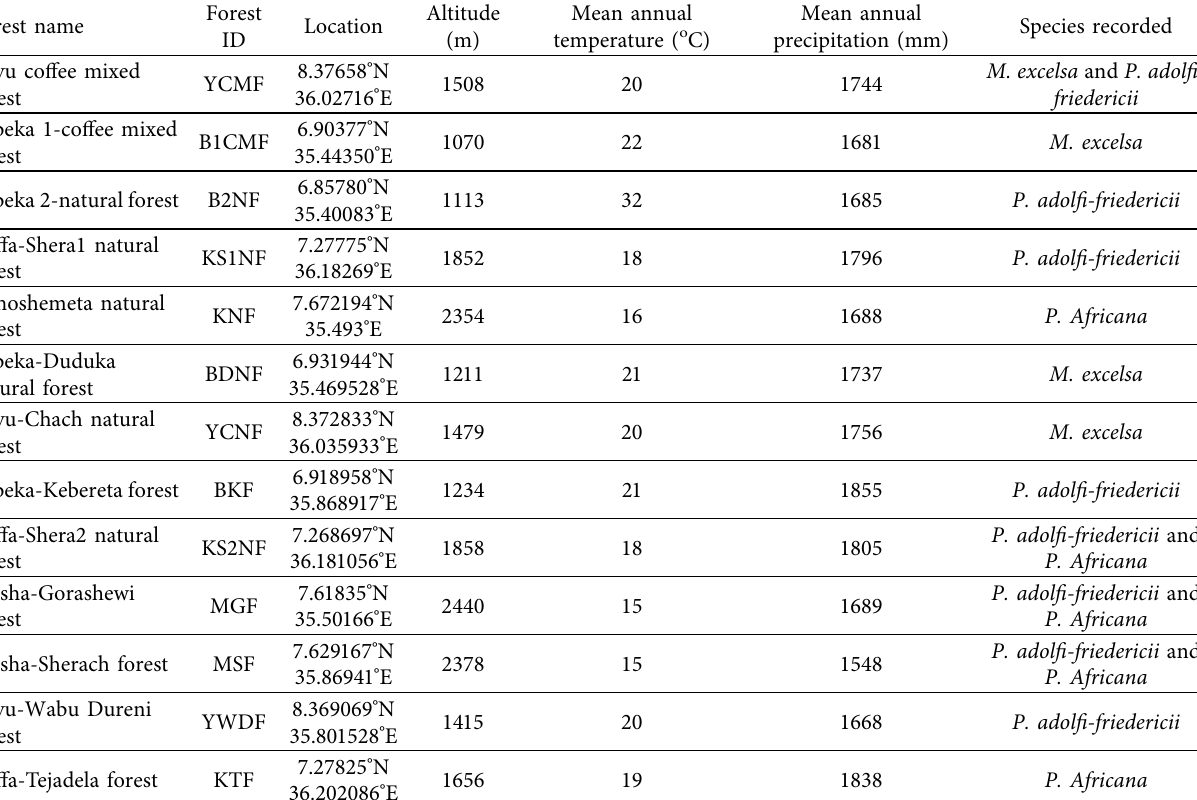
Table 1: Summary of biogeological characteristics of the sampling forest sites. Te mean annual temperature and precipitation each forest site are extrapolated from WorldClim version 2.1 climate data [15] using